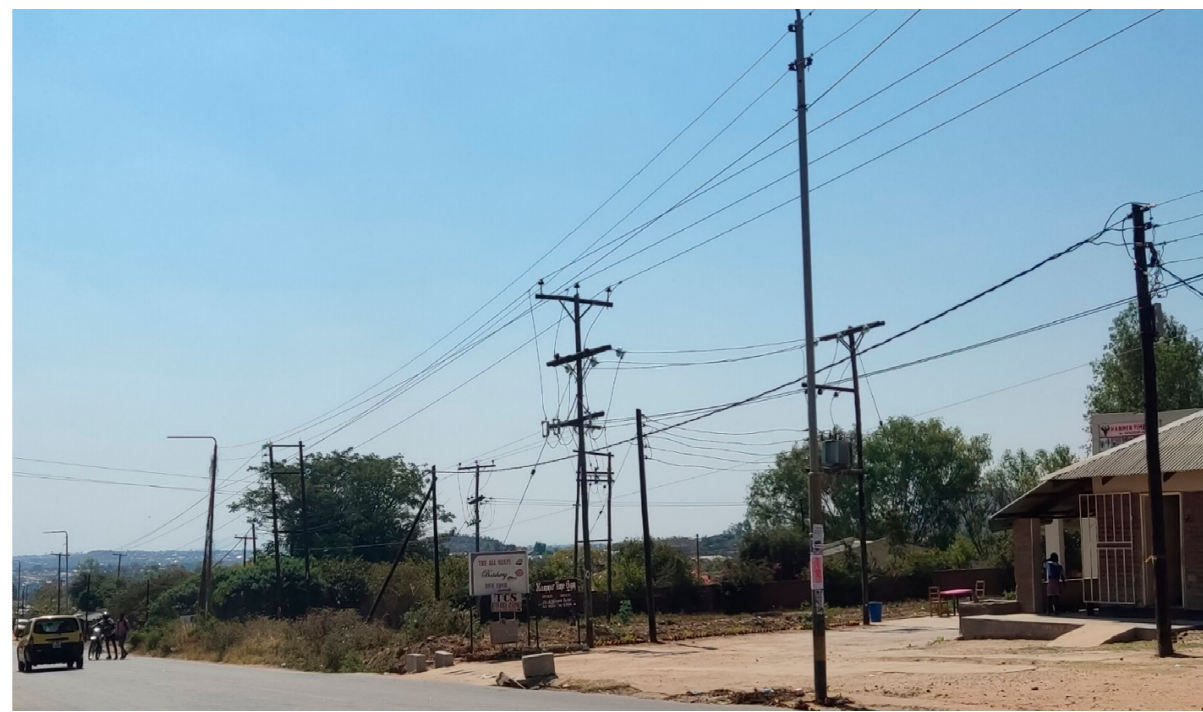
Figure 2. Technogenic sources of EMF pollution in one of the monitored residential areas.